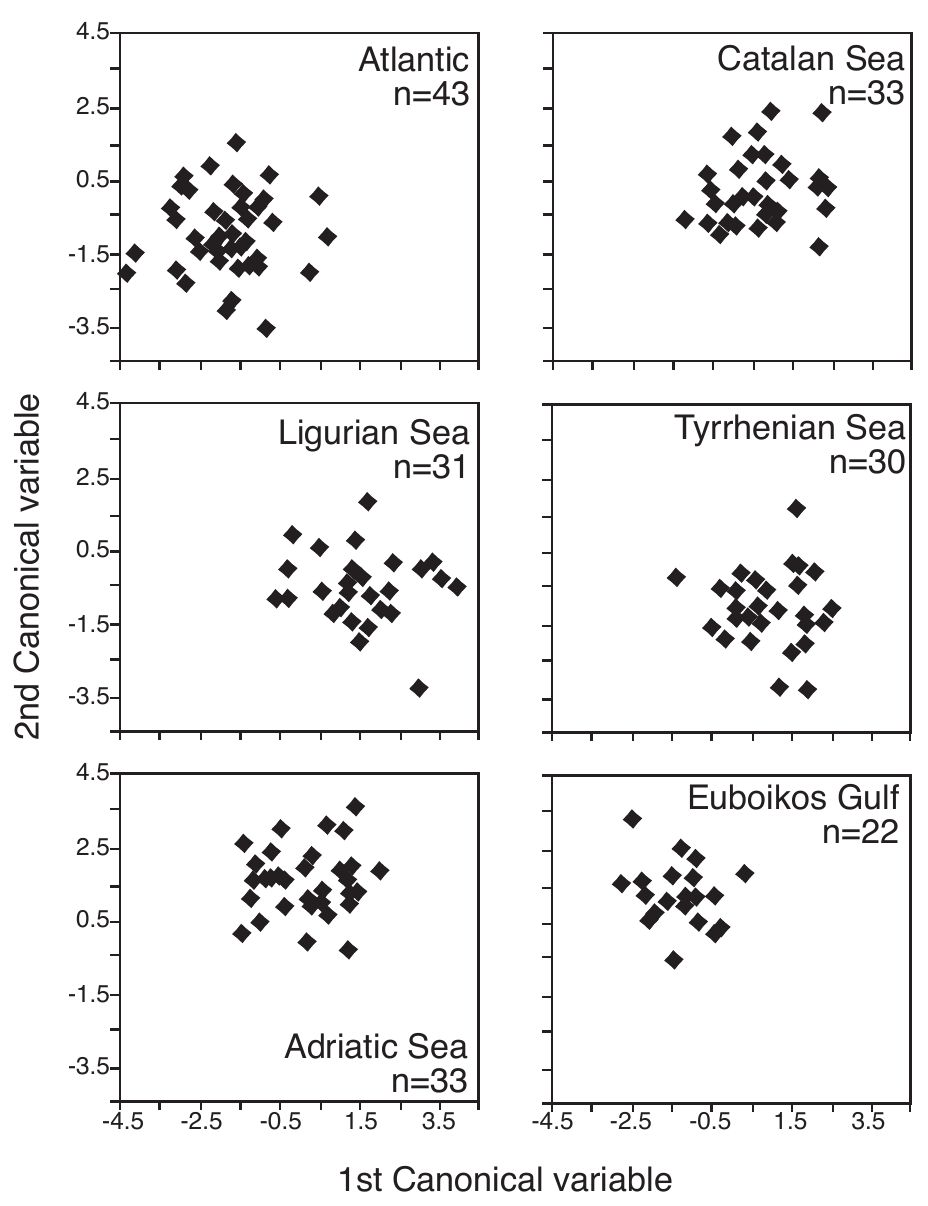
F IG . 1. – Plots of the individual scores for the first two canonical variables resulting from CVA. n, number of